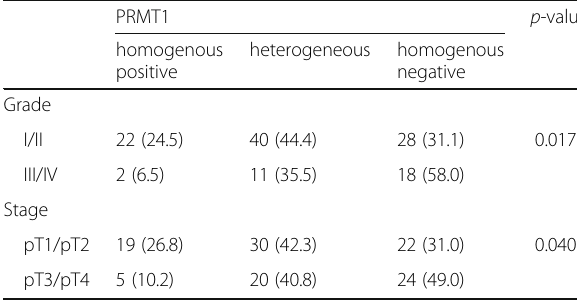
Table 6 Immunohistochemical heterogeneity of PRMT1 in ccRCC with different nuclear grade and